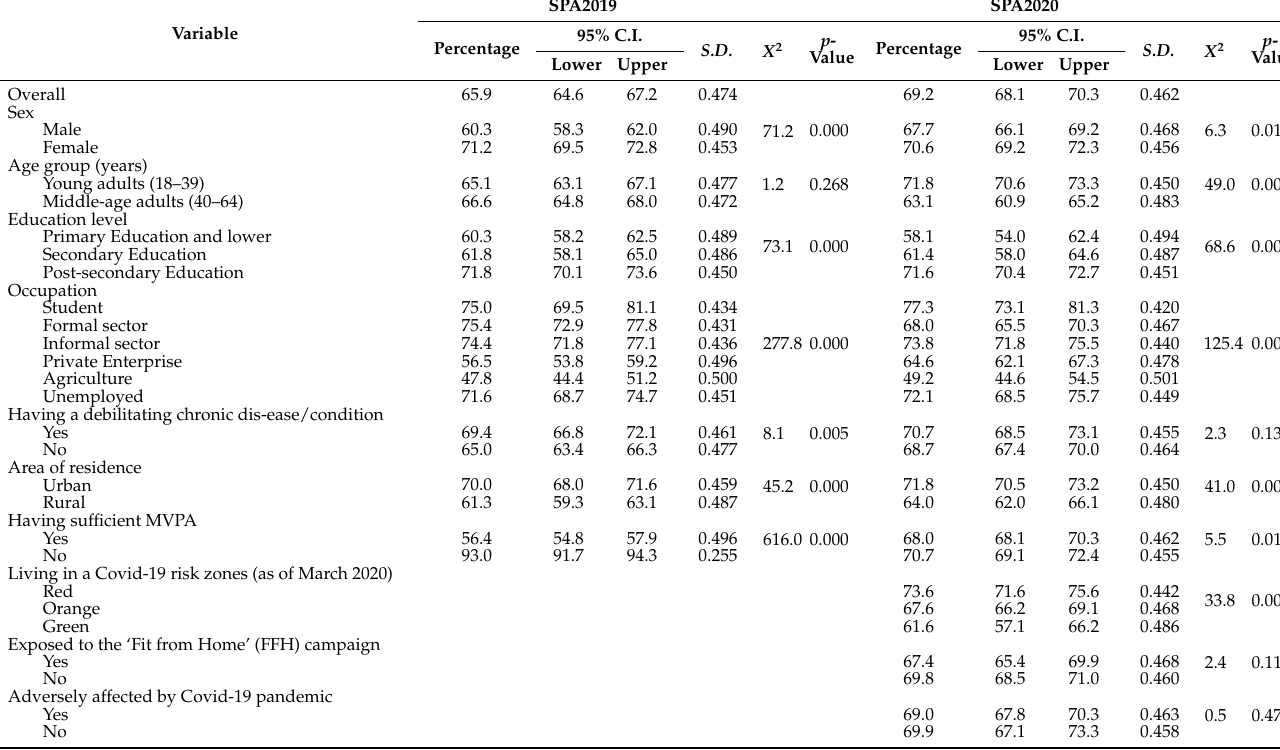
Table 2. Characteristics of sample with >13 h of SB per